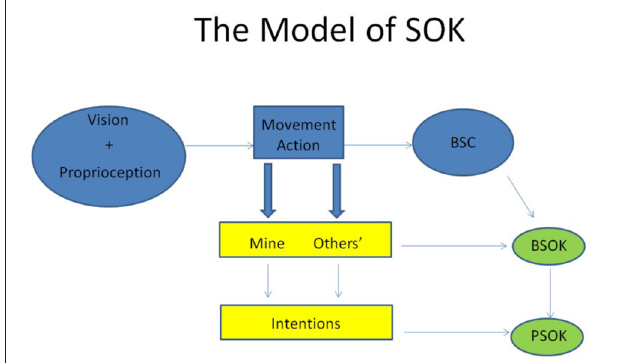
FIGURE 1 | The model of